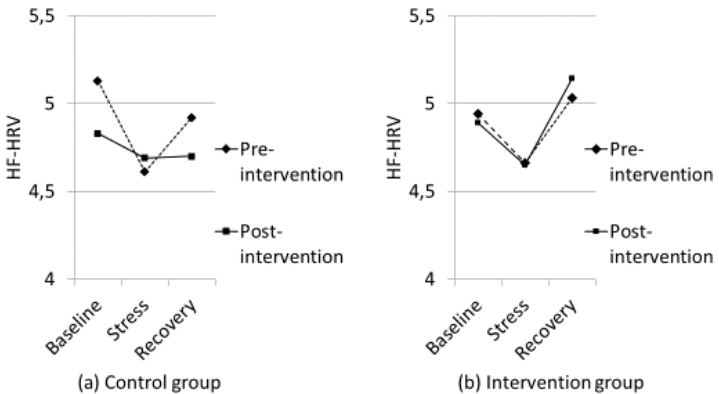
Figure 3. Psychophysiological responses (High-frequency Heart Rate Variability; HF-HRV) to baseline, stress (the average score for all cognitive tasks) and recovery for the Control group ( a ) and the Intervention group ( b ).